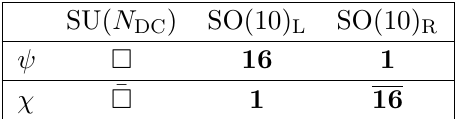
Table 6 . UV completion of the n f = 3 model with the choice of U(1) D charges in eq. (5.11). SM fermions are assumed to be charged under SO(10) L